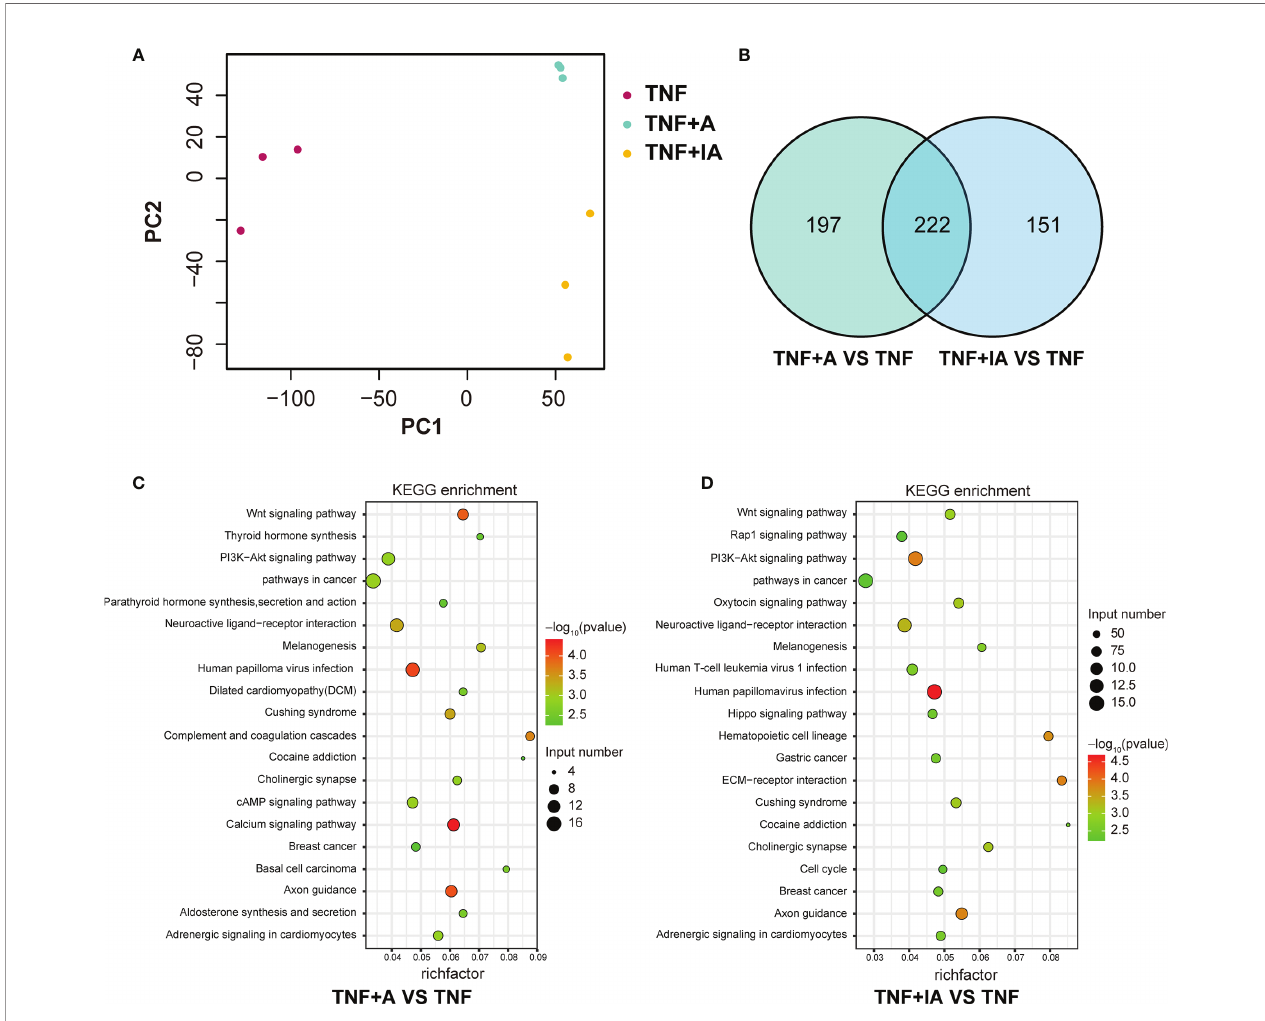
FIGURE 6 | Comparison of gene expression abundance and KEGG enrichment in T, and TNF+A and TNF+IA groups. (A) The principal component analysis based on the RNA-Seq data. (B) Venn diagrams of differentially expressed transcripts. (C) The top 20 KEGG pathways enriched in TNF+A group compared to group TNF. (D) The top 20 KEGG pathways enriched in TNF+IA group compared to group TNF. TNF, cells challenged with 20 ng/mL Recombinant Susscrofa TNF- a for 48 hours. TNF+A, cells challenged with 20 ng/mL TNF- a for 40.5 h and then co-cultured with 10 8 copies/mL active A. muciniphila for 7.5 h. TNF+IA, cells challenged with 20 ng/mL TNF- a for 40.5 h and then co-cultured with 10 9 copies/mL inactive A. muciniphila for 7.5